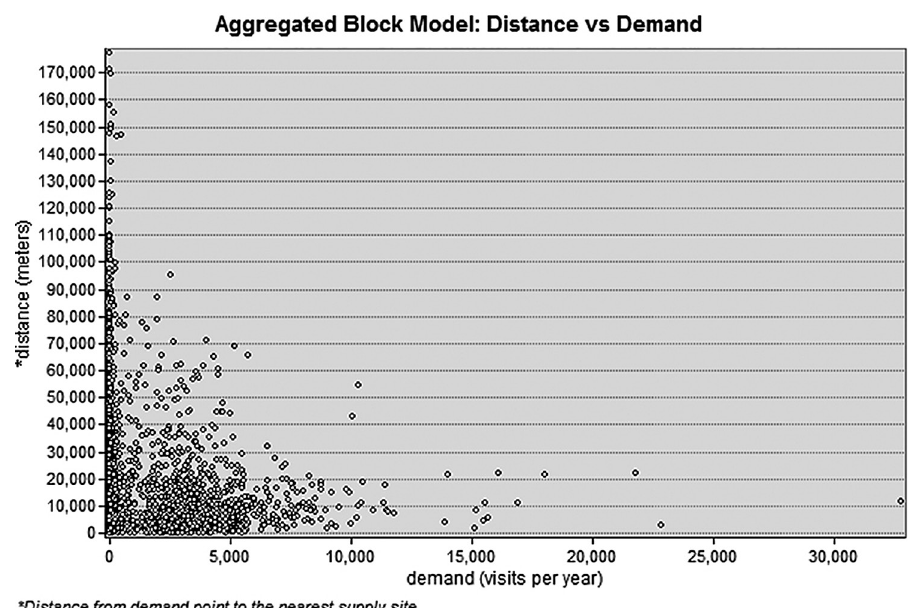
Fig. 6. Aggregated block model: distance vs.